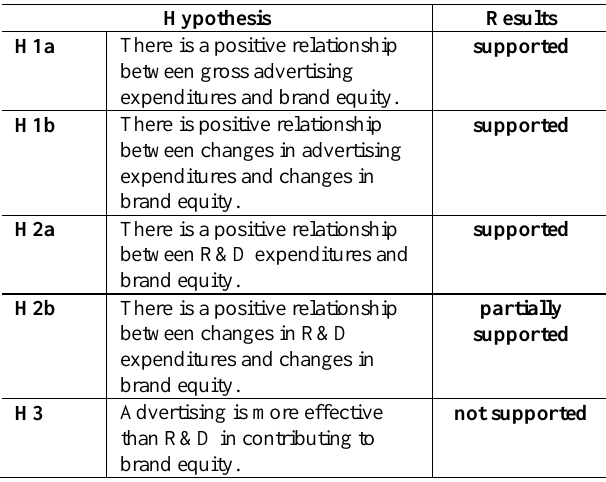
Table 2: Summary of hypothesis tests Hypothesis